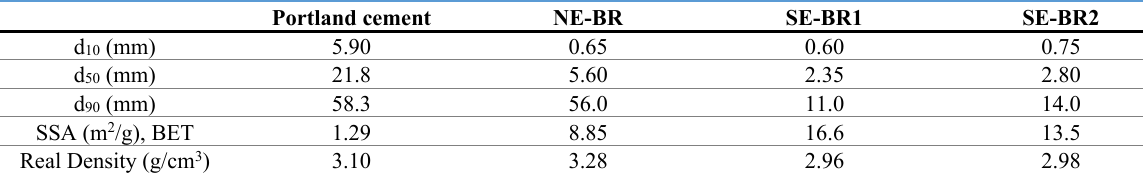
Table 5 R eal densities, specific surface area (SSA), d10, d50, and d90 of each material. Portland cement NE-BR SE-BR1